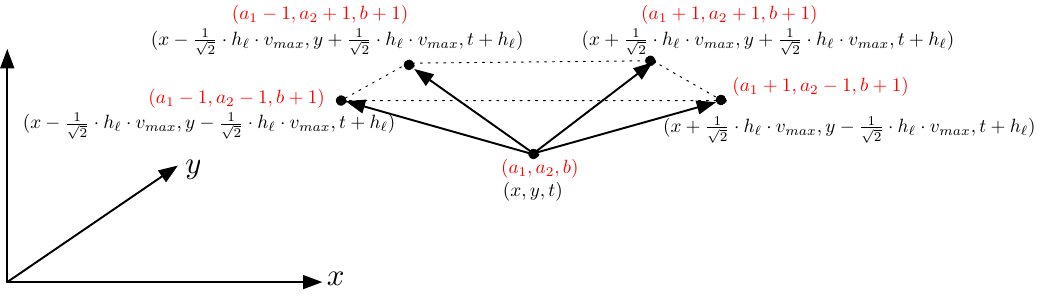
Figure 8. The four possible moves in a two-dimensional random walk. The local coordinates are shown in